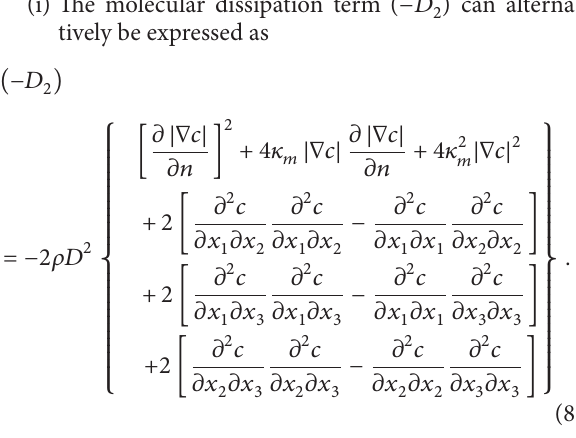
(Figure 15) for cases P3 and V2, and the correlation coef- ficients between 𝑓(𝐷) and 𝑎 𝑇 ( 𝜅 𝑚 ) for different 𝑐 isosur- faces across the flame for cases P3 and V2 are shown in Figures 16(a) and 16(b) (Figures 16(c) and 16(d)),